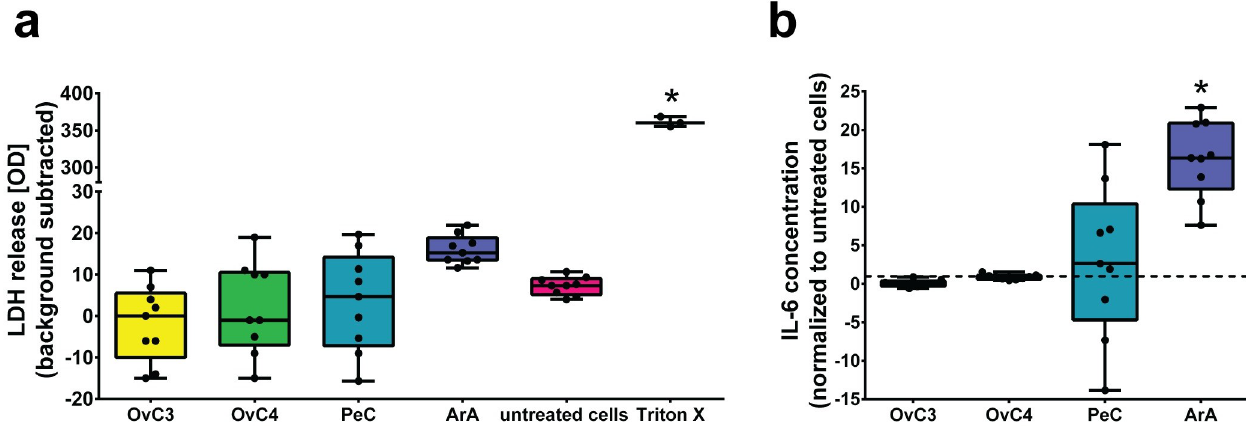
Fig 1. Cell viability and IL-6 secretion of ascites-exposed MeT-5A cells. a) LDH absorbance of cells exposed to ascites, untreated cells, and cells exposed to the positive control Triton ™ X-100 (background subtracted); � p -value < 0.0001. b) IL-6 secretion of cells exposed to ascites, normalized to untreated samples (dotted lines); � p -value < 0.05. Data are presented as median ± Min/Max, n = 3.